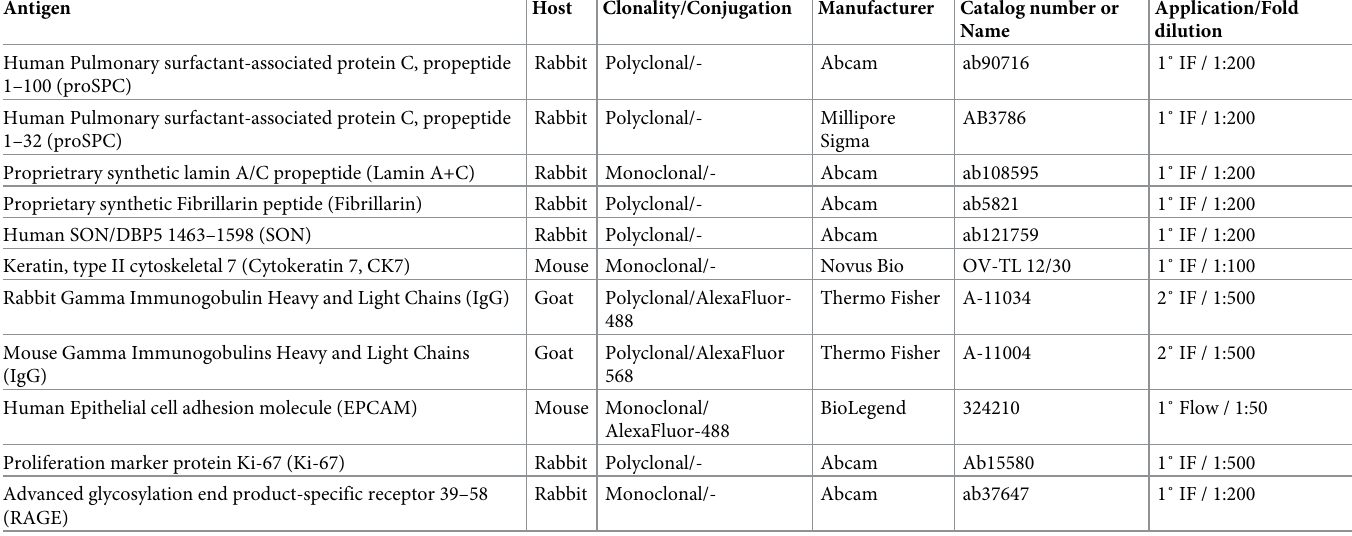
Genomes of oversized lung adenocarcinoma cells are physically expanded Given the correlations observed between cell and nuclear volume, and findings that changes in chromatin organization can be observed in cancer, we asked whether DNA staining displayed any special patterns in LA nuclei. We observe five common classes of DNA staining, and mix- tures of these that describe most DNA data in LA (Fig 8A). Normal AT2 cells have mostly even DNA-staining profiles, with little granularity, and are so consistent that neoplasms are usually conspicuous. In LA, the most common pattern consists of a granular appearance suggestive of local heterochromatic regions. Cytoplasmic inclusions are ringed by concentrations of DNA at their boundary. Lamin-associated DNA is concentrated at the nuclear periphery and some- times at the periphery of inclusions. DNA voids consist of large volumes that stain poorly for DNA, but are otherwise not significantly bordered. “Wagon-wheel” arrangements are reminis- cent of nucleoli, but may not contain them, as suggested by weak DNA staining at their central “hub” regions. Table 6. Primary and secondary antibodies used in this